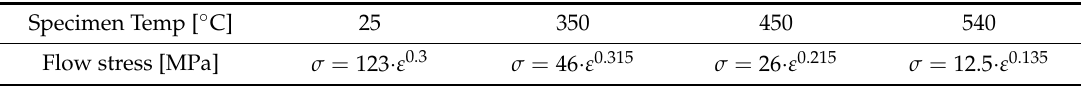
Table 3. Flow-stress relations for Al1050 at different temperatures as determined from the iterative process. Specimen Temp [ ◦ C] 25 350 450 540 Flow stress [MPa] σ = 123 · ε 0.3 σ = 46 · ε 0.315 σ = 26 · ε 0.215 σ = 12.5 · ε